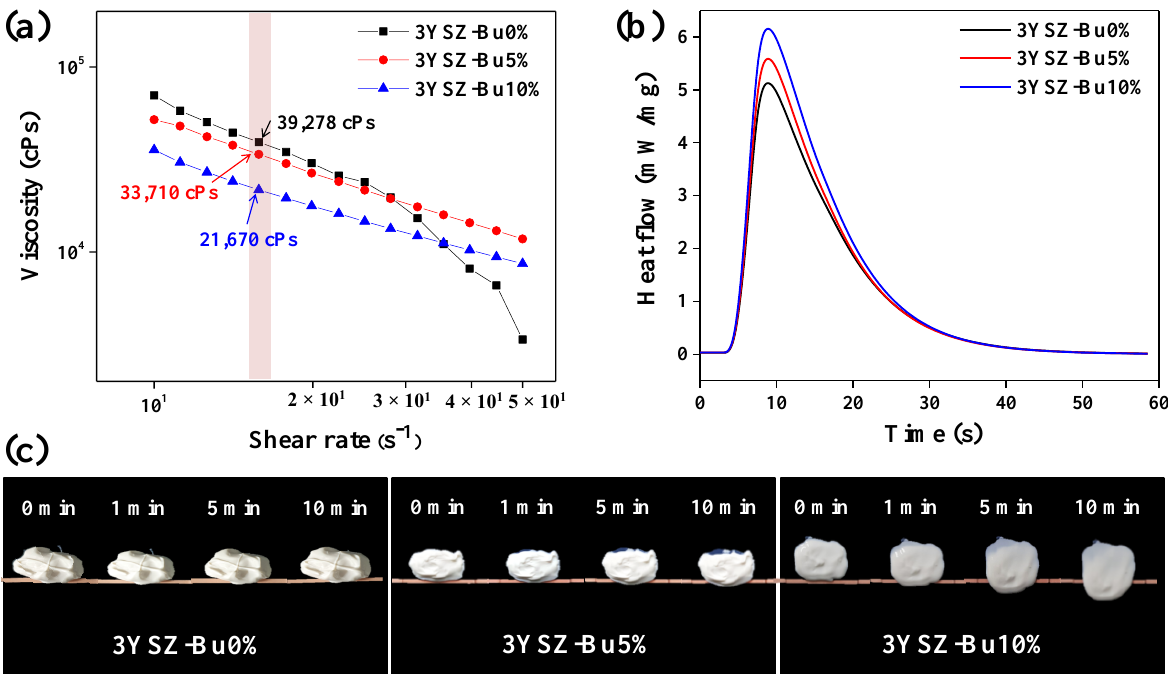
Figure 1. Characteristics of UV-curable 3YSZ ceramic nanocomposite resins with different Bu content: ( a ) Viscosity behavior, ( b ) heat flow curves, and ( c ) flowability.